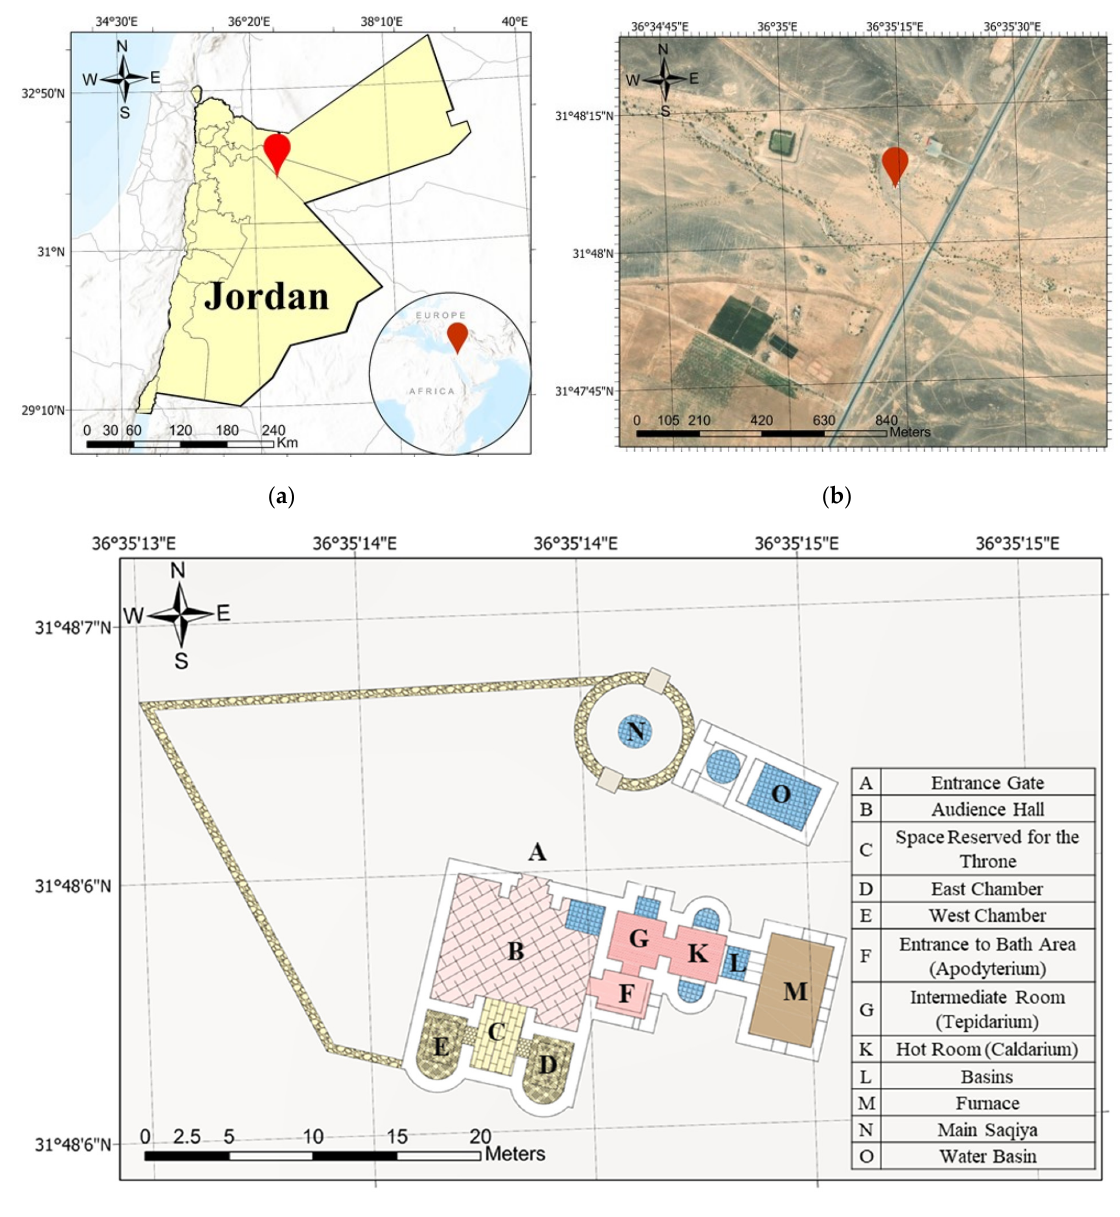
Figure 1. Location of Qaser Amra in Jordan: ( a ) Location of Jordan; ( b ) Landsat image of Qaser Amra; ( c ) Detailed top plan modified by the authors (Ref. Department of Antiquities of Jordan).